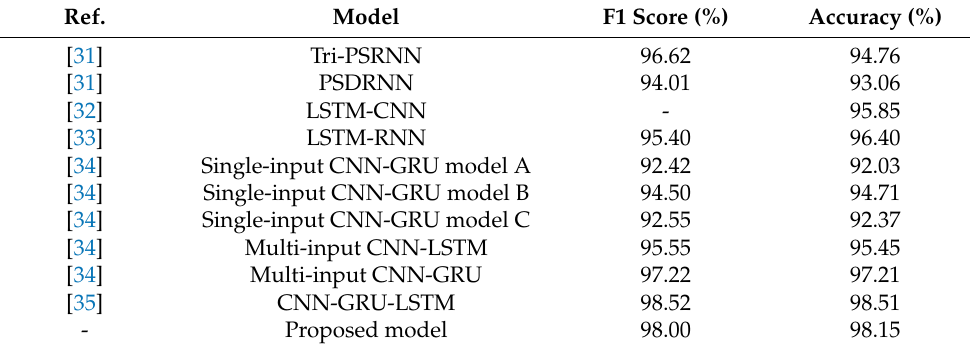
Table 4. Evaluation of the proposed model compared with models based on RNN.